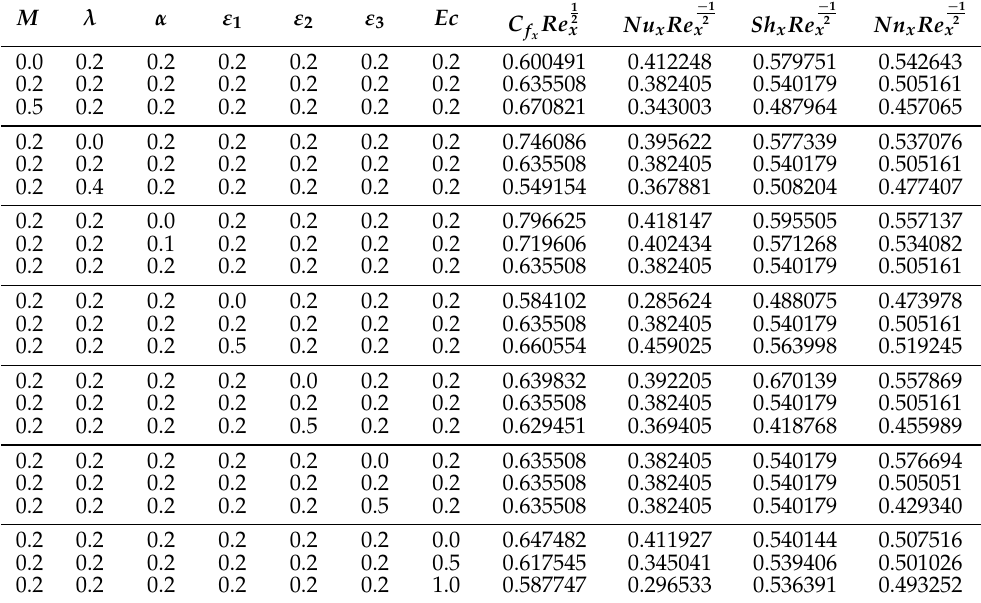
Table 3. Values for C f and ε 3 , with Pr = 1.5, Sc = 2.0, Pe = 0.6, W e = 0.4, σ = 0.2, and Sb =